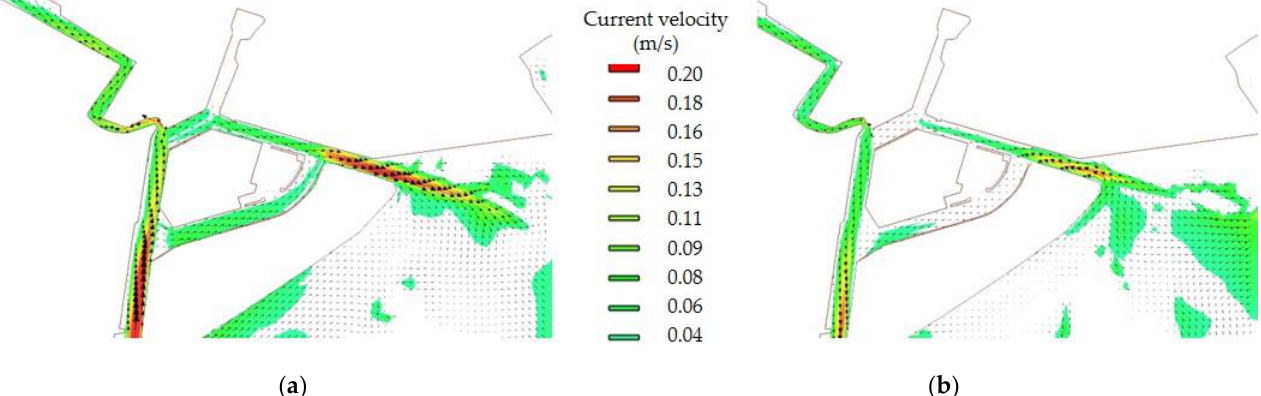
Figure 8. Simulation of Bora and tidal oscillations. Contour and vectors of the maximum current: ( a ) during flood tide; ( b )